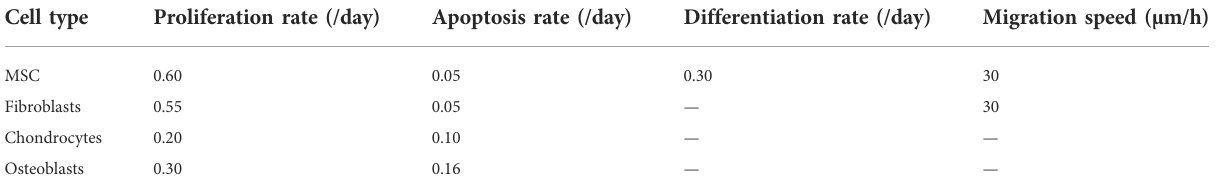
TABLE 3 Cell activity rates [adapted from (Checa et al., 2011)].